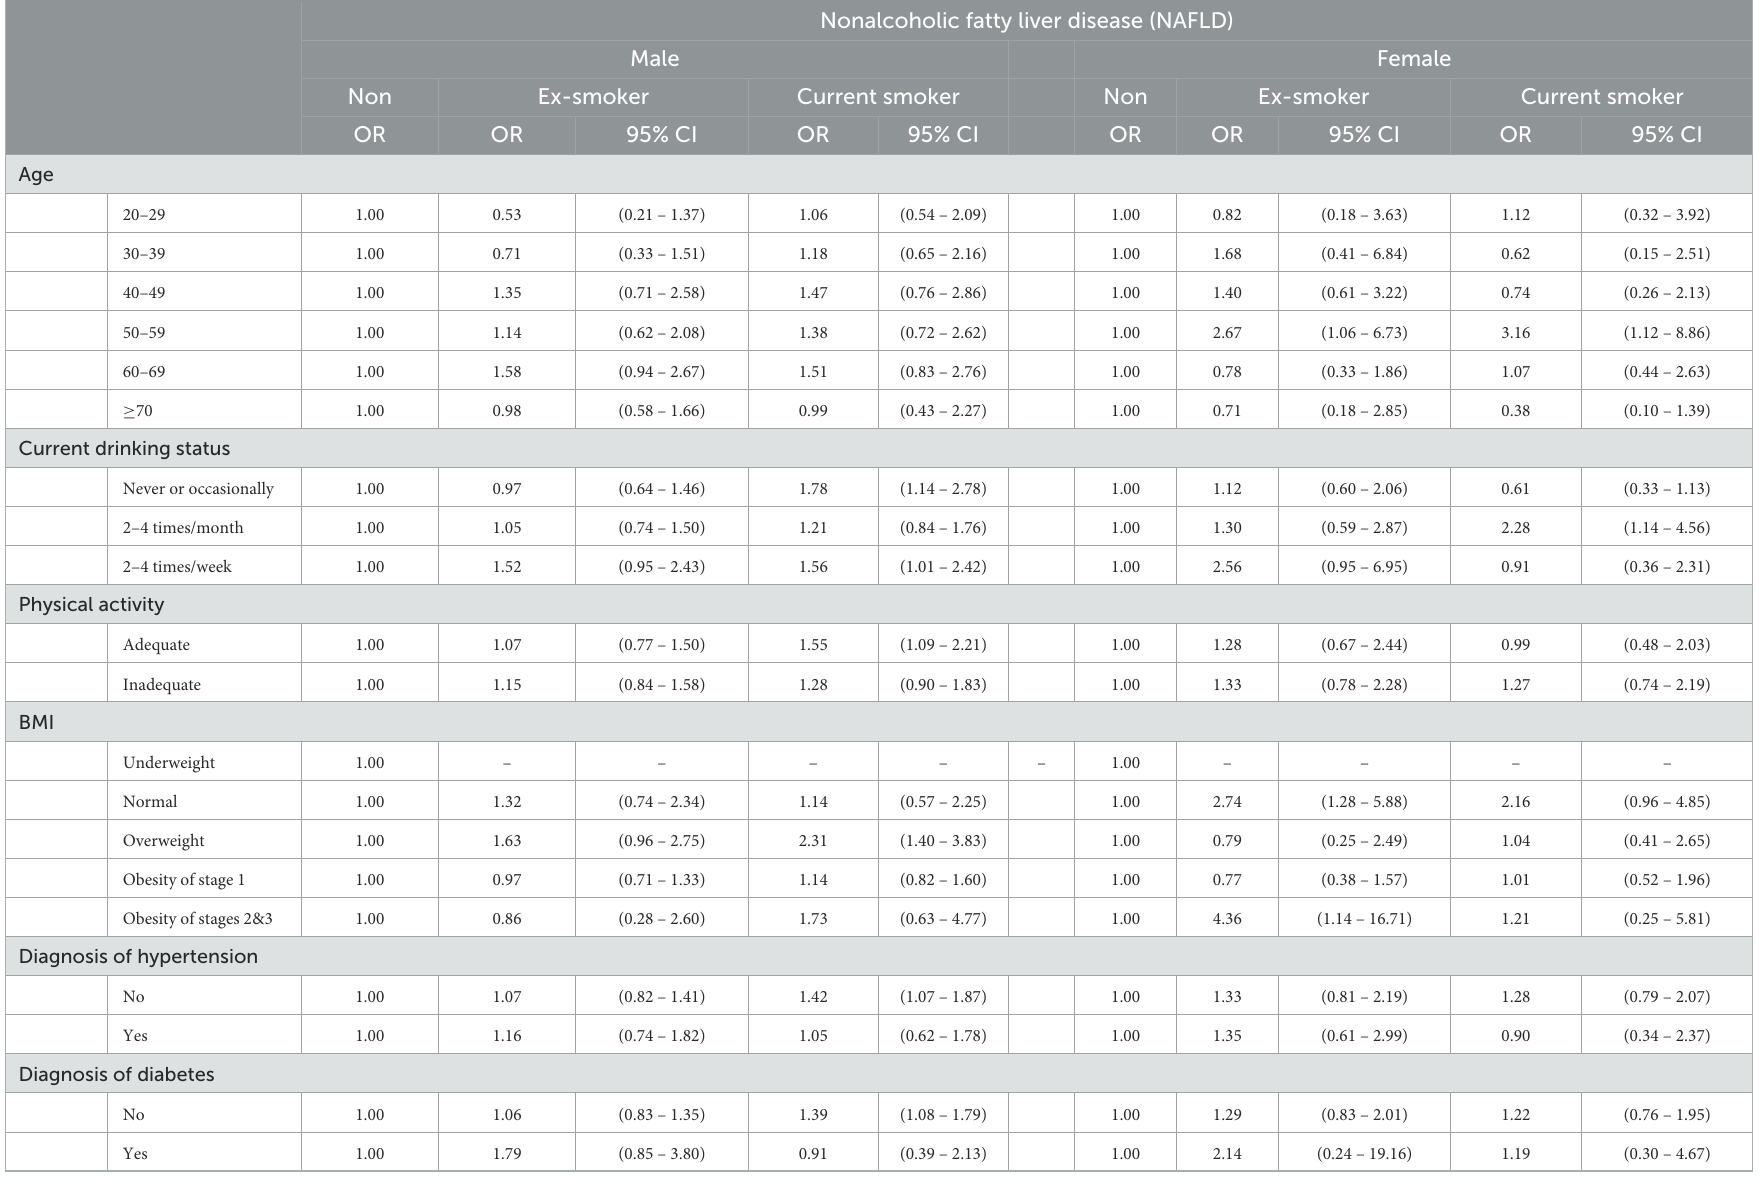
TABLE 3 Results of subgroup analysis stratified by independent